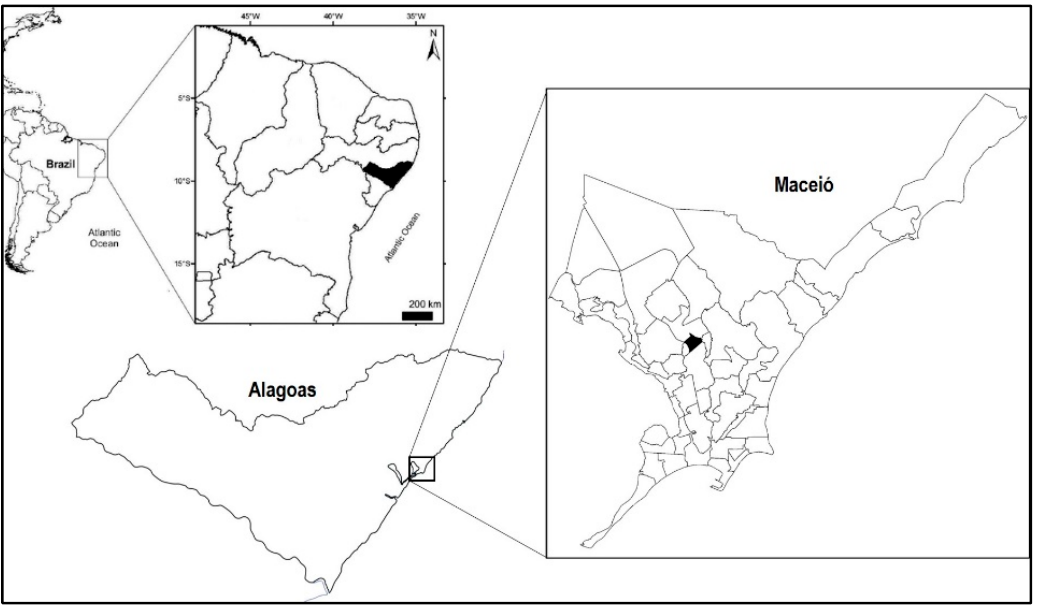
Figure 1. Geographical location of the study area.